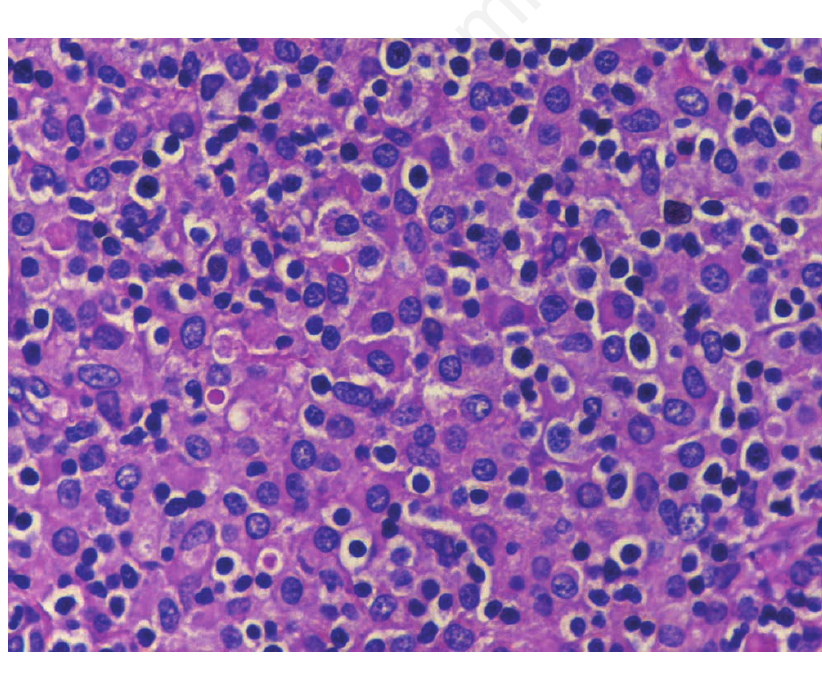
Figure 1. Lymph node (hematoxylin and eosin): a dense infiltrate of histiocytes including small reactive lymphocytes.